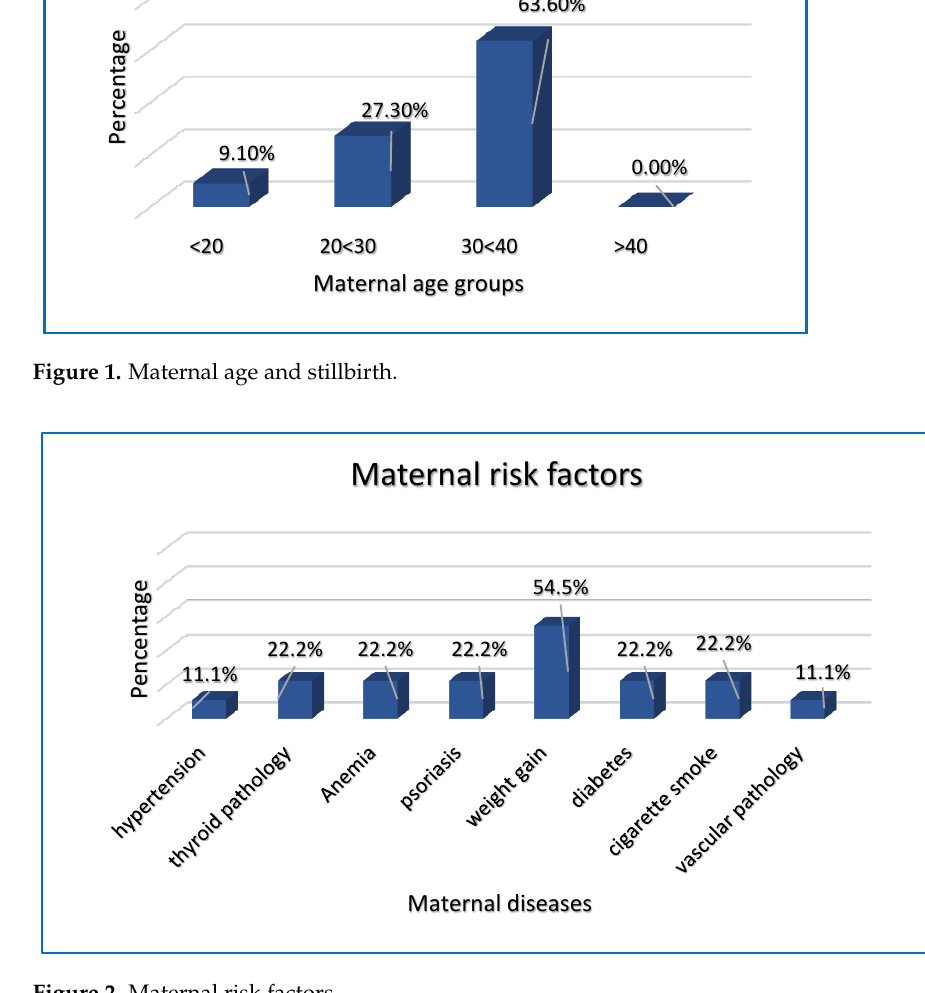
Figure 1. Maternal age and stillbirth.